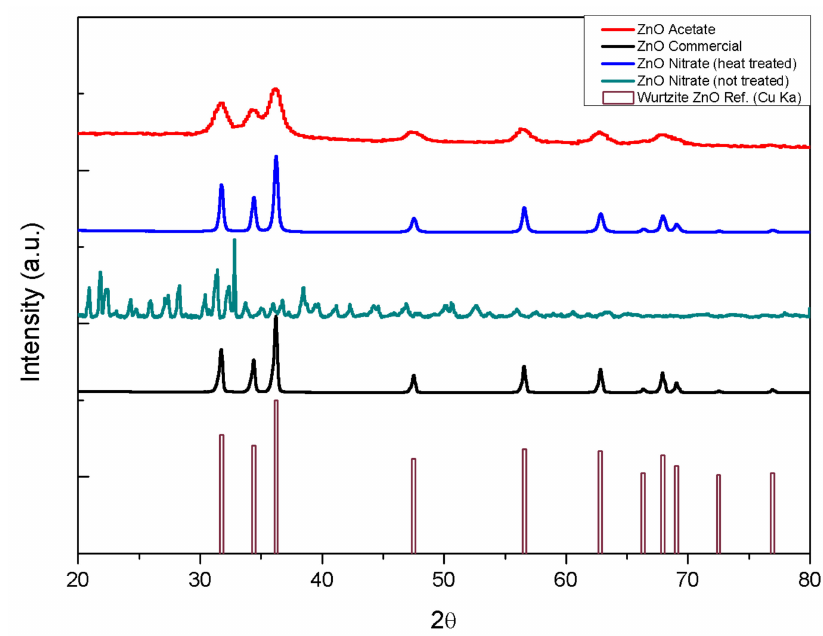
Figure 1. XRD experimental spectra obtained from synthesized samples compared to ZnO hexagonal Wurtzite reference spectrum (retrieved from Pearson’s Crystal Data database, n ◦